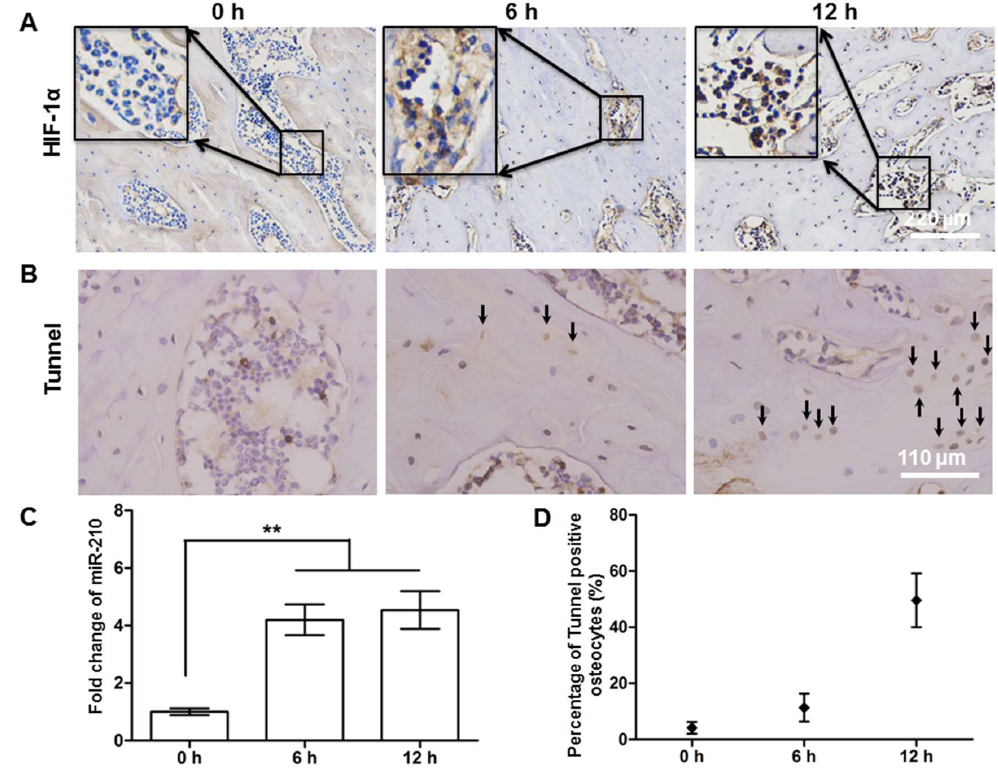
Figure 6. Histological examination of classic avascular osteonecrosis: ( A ) Immunohistochemical manifestation of HIF-1α in different postoperative stages; ( B ) tunnel staining of femoral heads, the positive osteocytes are shown with black arrows; ( C ) HIF-1α mRNA levels analyzed by real-time PCR; ( D ) the percentage of Tunnel positive osteocytes. ** p < 0.01, by a two tailed unpaired t